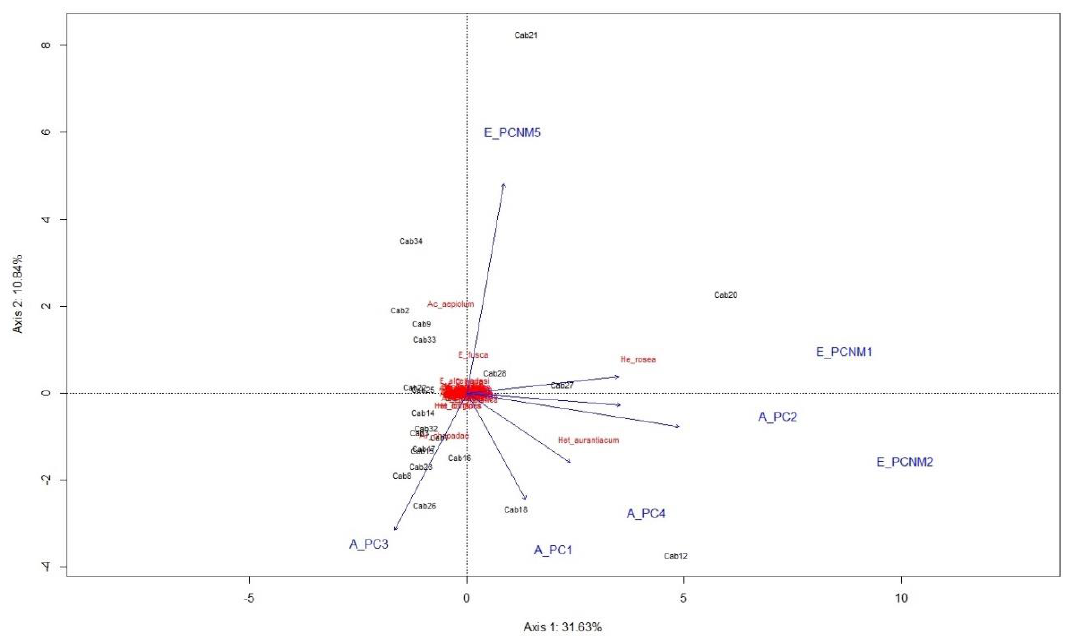
Figure 4. Result of the redundancy analysis showing the relationships among spatial variables and environmental variables with the sample sites and adult individuals of Odonata. A _= Environmental variable axes and E_ = Spatial variable axes.